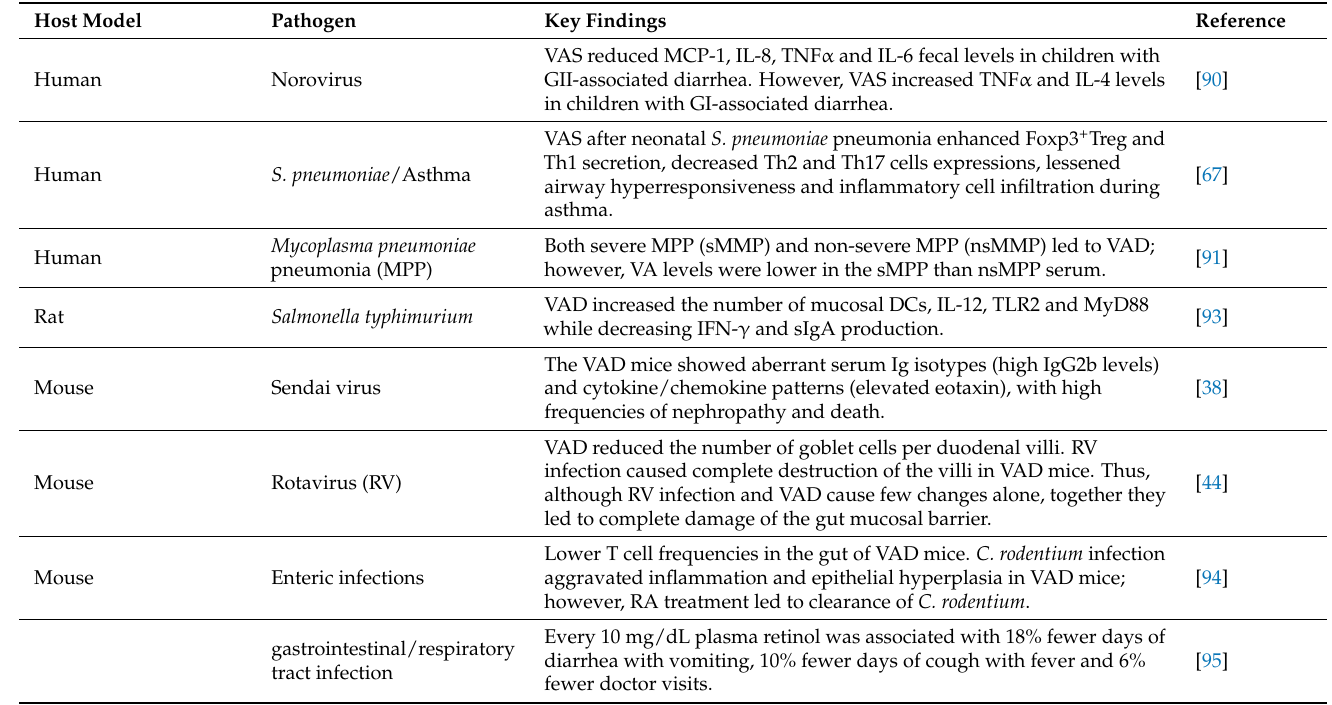
Table 2. Effects of VAD on immune responses to vaccination observed in individual clinical studies and animal model